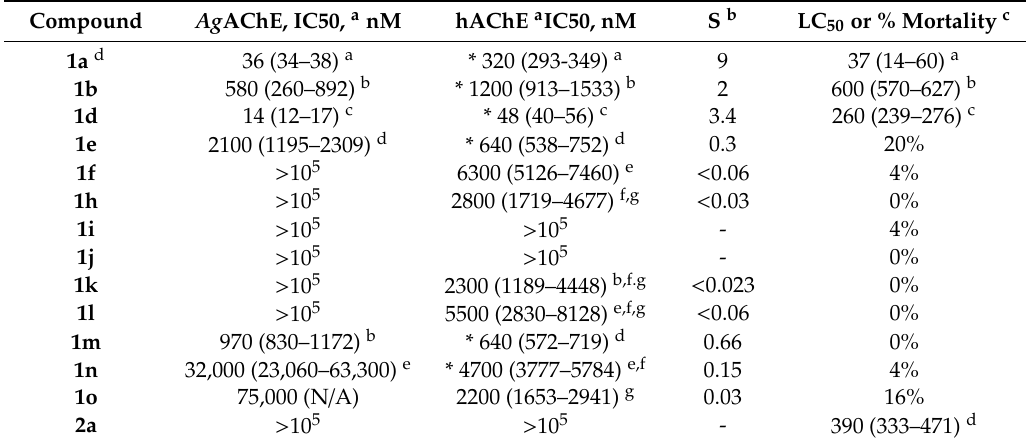
Table 1. AChE inhibition and mosquito toxicity to adult female An. gambiae by 3- tert -butylphenyl carbamate 1a and the substituted analogs shown in Figure 1.